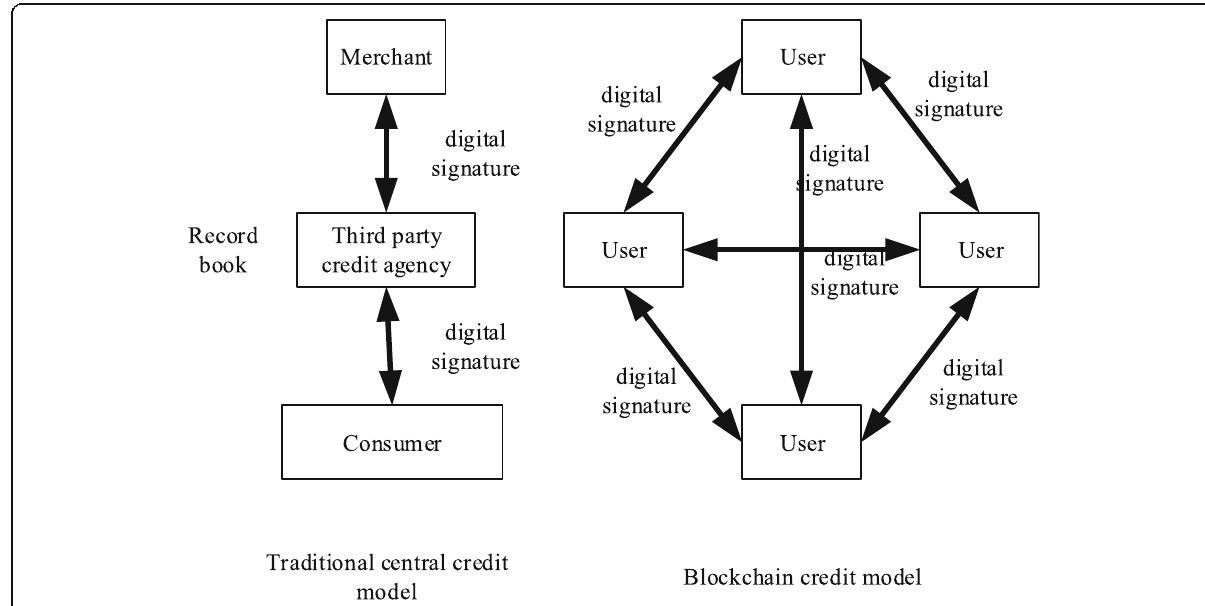
Fig. 4 Comparison between the traditional centralization credit mode and the block chain network